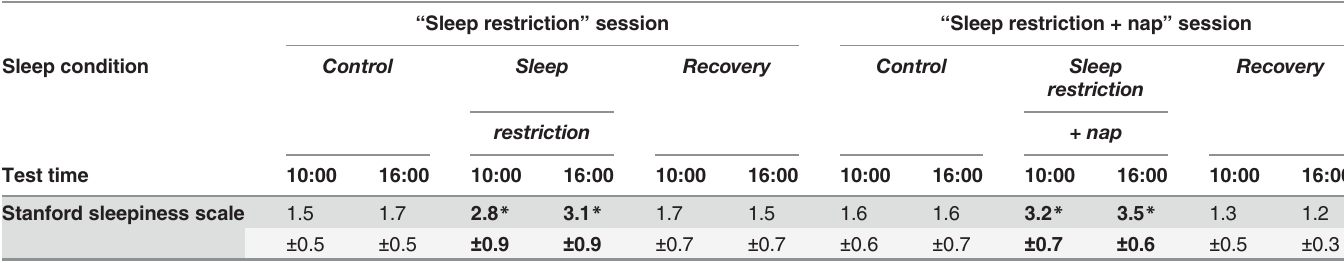
Table 5. Stanford sleepiness scale after sleep restriction without or with